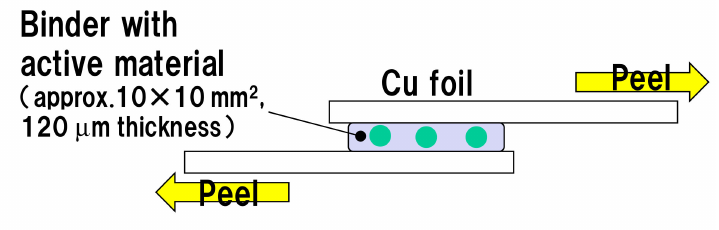
Figure 2. Cross-sectional image for shear peeling test. Ketjenblack ® , KB.